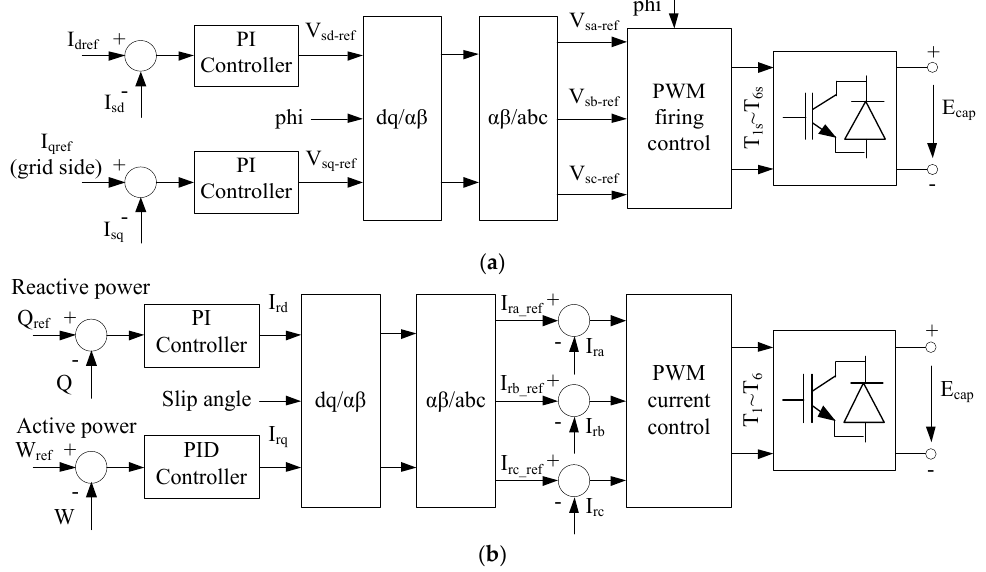
Figure 3. Block diagrams of induction machine control for the DFIG tidal current turbine, ( a ) current reference Pulse Width Modulation (PWM) based rotor side converter and ( b ) synchronised PWM based grid side converter.